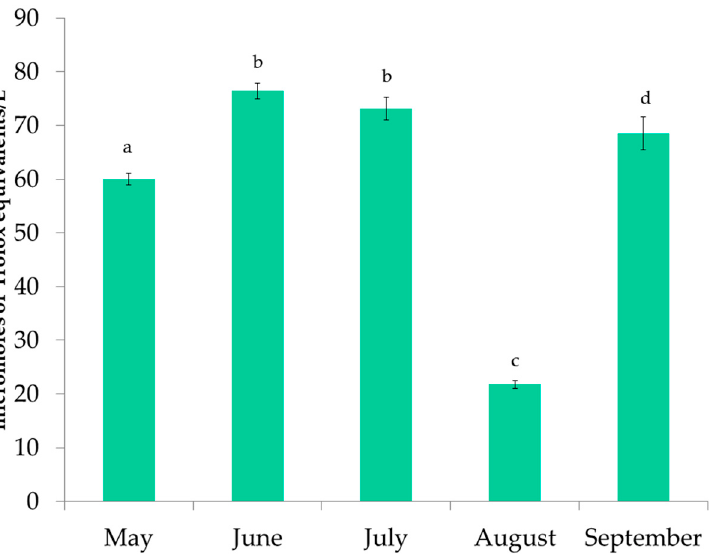
Figure 6. ORAC results for extracts of P. pavonica harvested from May to September. a–d different letters denote statistically significant difference.